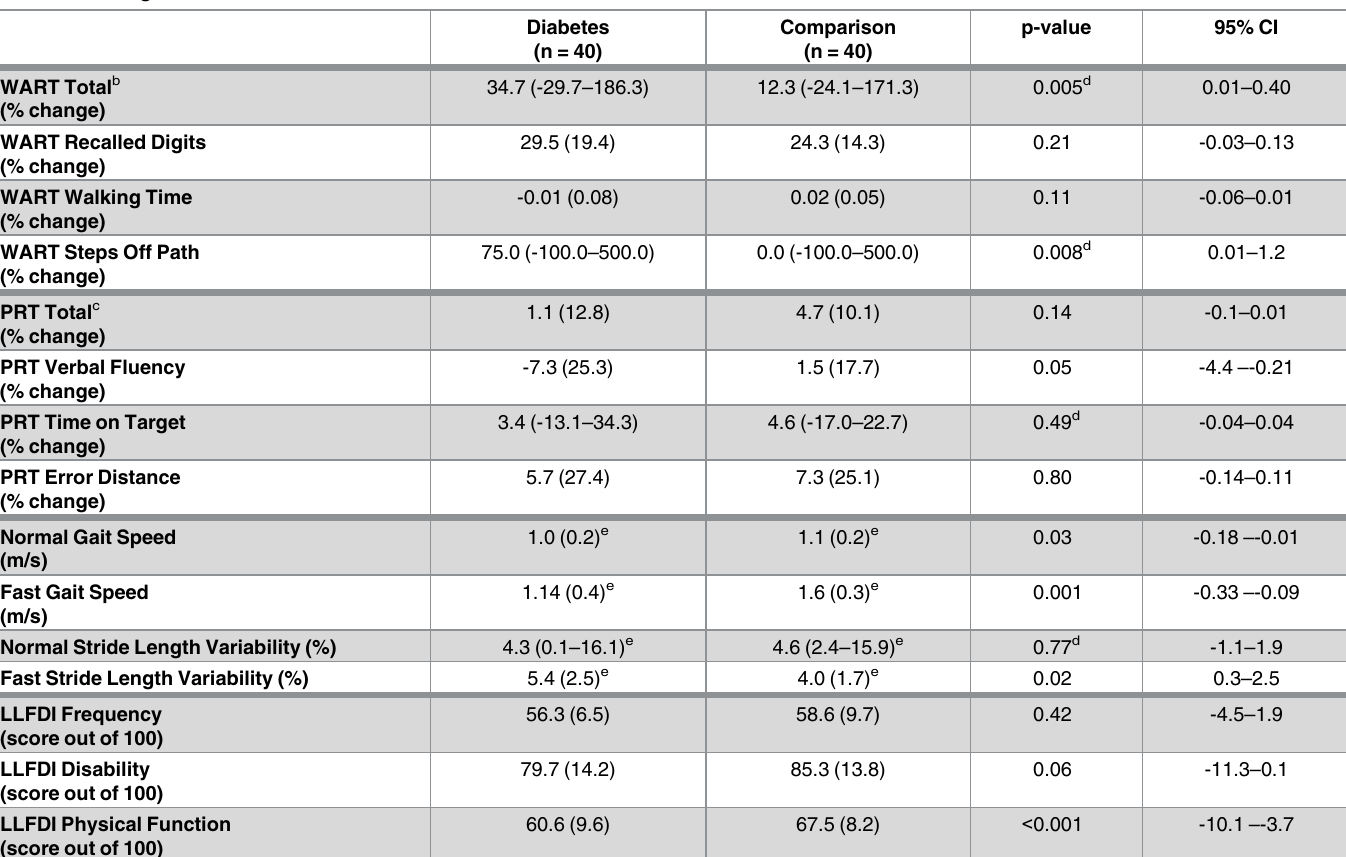
Table 2. Testing results a